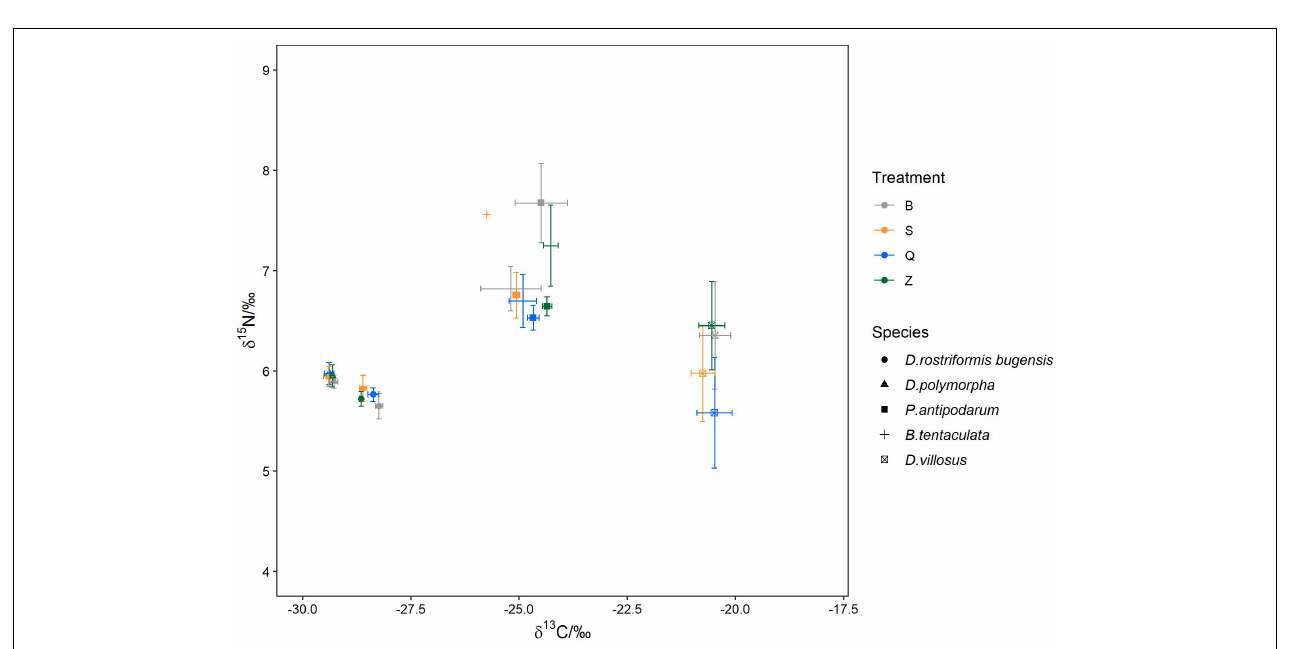
FIGURE 3 | (A) Mortality rates of adult living quagga and zebra mussels glued on the stone substrates. D.rostriformis bugensis is the adult mussel used in Q treatments and D. ploymorpha is the adult mussel used in Z treatments. (B) Linear regression (solid line) and the 95% confidence interval of the regression (dotted line) for abundances of newly settled chironomid larvae (subfamily Chironominae) and mortality rates of adult dreissenids.